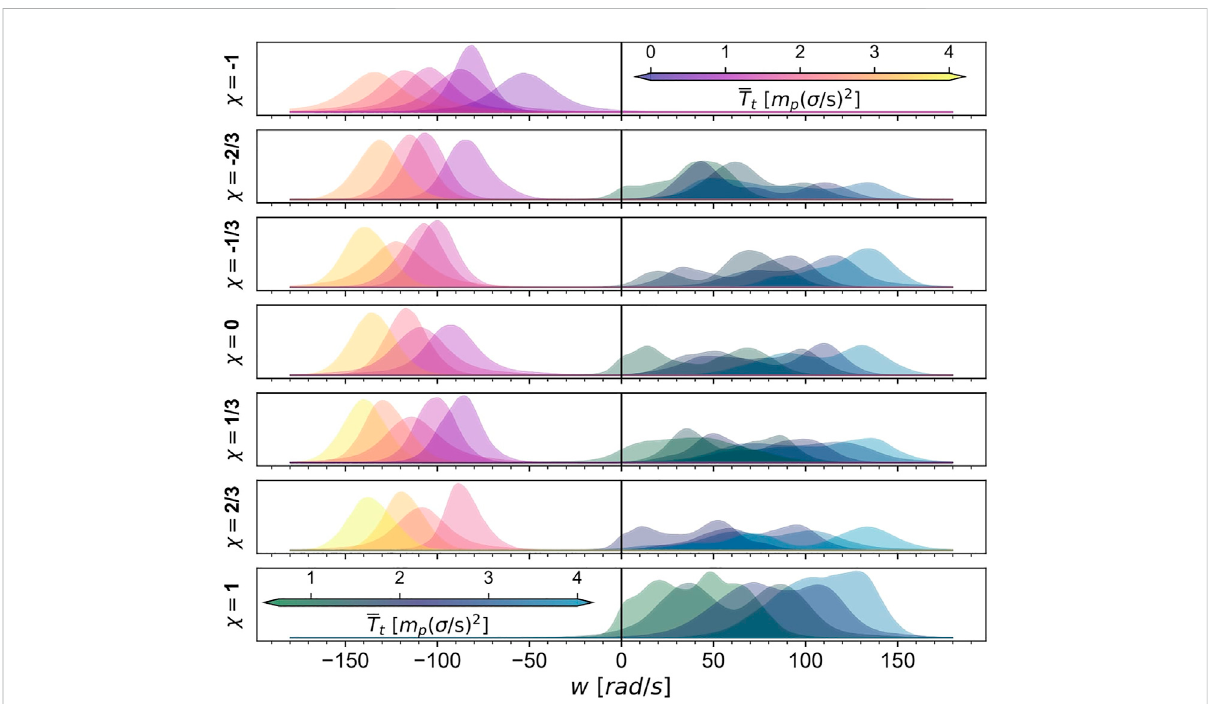
FIGURE 4 Marginal distribution function rotational f r , v (w) (right) velocities (the subindices r , v , w indicate an average over those quantities). Each row contains the distribution functions for all experiments with a given relative species density. We show self-spinning distribution functions for the fi rst species spinners (brighter shades of purple represent higher system translational energies) and species-2 spinners (shades of green).